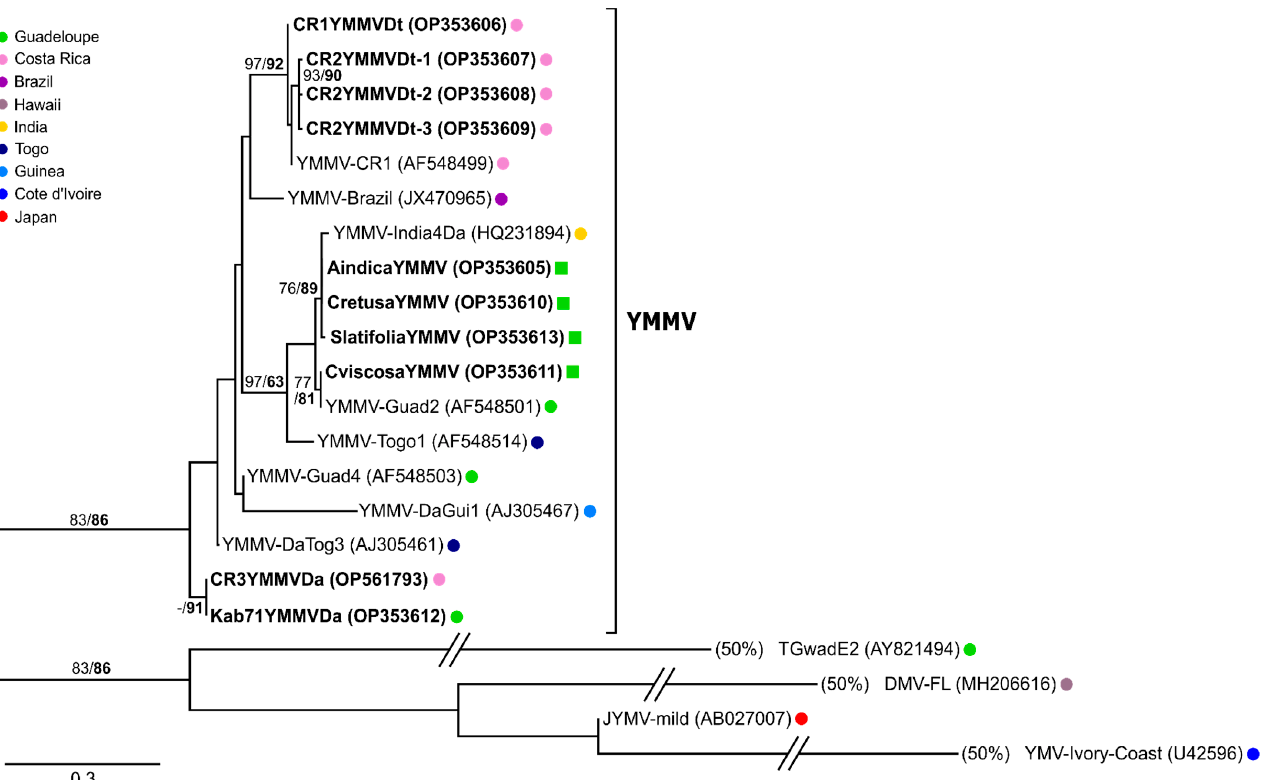
Figure 7. Maximum Likelihood phylogenetic tree showing the relationships between YMMV sequences generated in this study (in bold) and similar sequences from previously characterised YMMV isolates. Phylogenetic analyses were performed on the coding part (139 nt) of the amplified sequences, corresponding to nucleotide positions 9257–9395 in the genome of YMMV-Brazil. An arbitrary root was positioned at the branch separating YMMV from other potyviruses infecting yam. Branches leading to the three sequences at the bottom of the tree were shortened to 50% of their original length in order to fit in the figure. Sequences obtained from yam are represented by coloured dots and those from weeds by coloured squares. The key to the colour dots referring to the location of the samples from which sequences originated is shown in the box on the left of the tree. SH-aLRT (in normal font) and UFBoot (in bold) values shown above branches are expressed in percent of the sampled trees.